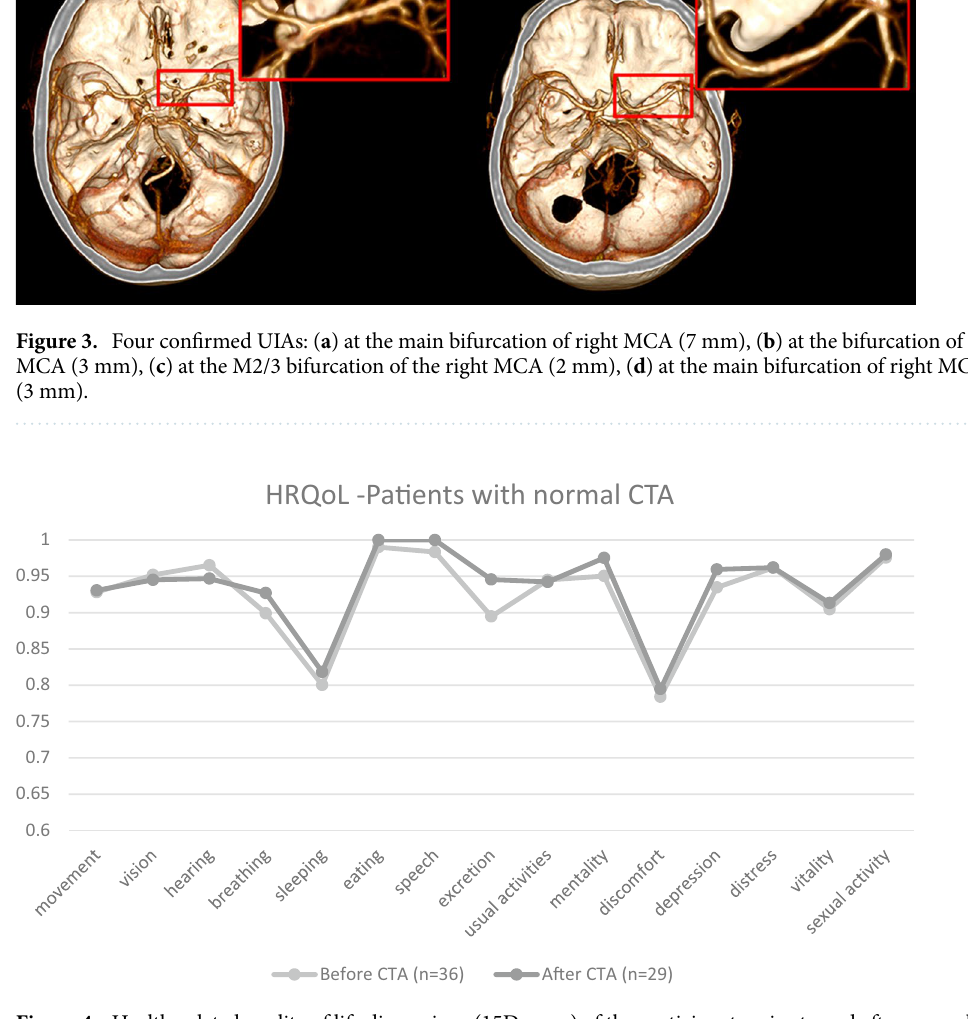
Figure 4. Health-related quality of life dimensions (15D score) of the participants prior to and after normal CTA